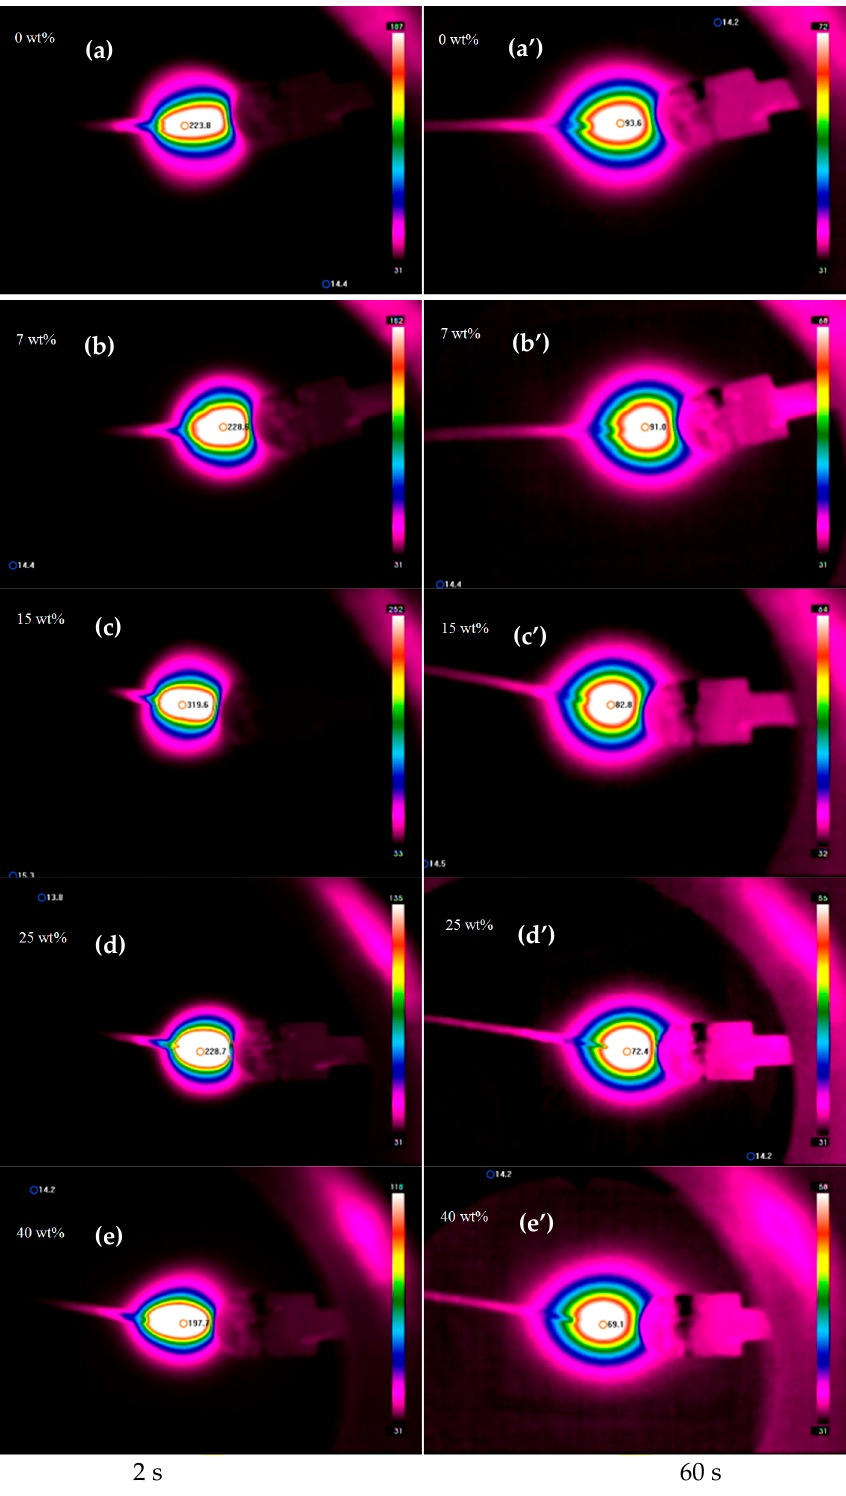
Figure 11. Infrared thermographs on the surface of the front side samples of nanocomposites with different weight fractions recorded 60 s after breakdown. ( a ~ e ): infrared thermographs 2 s after breakdown; ( a ′ ~ e ′ ): infrared thermographs 60 s after breakdown.